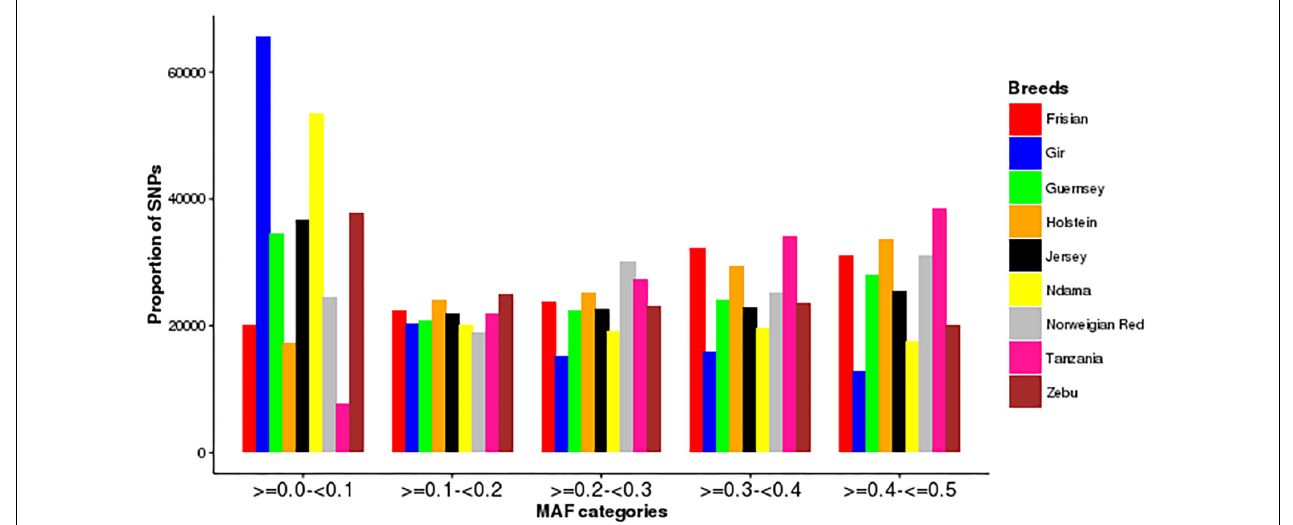
FIGURE 1 | Distribution of minor allele frequencies (MAF) in the study